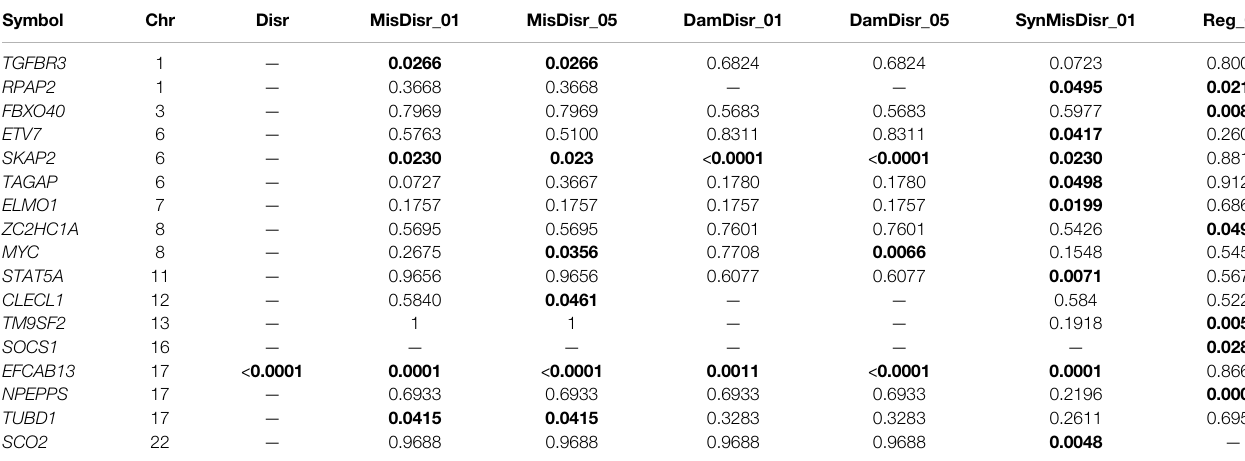
TABLE 3 | Genes nominated for